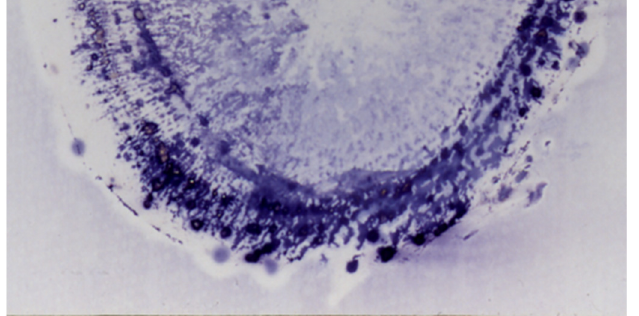
Figure 2. Ginsenoside Rb1 distribution in fresh ginseng root using the anti-ginsenoside Rb1 mono- clonal antibody (author’s unpublished data).